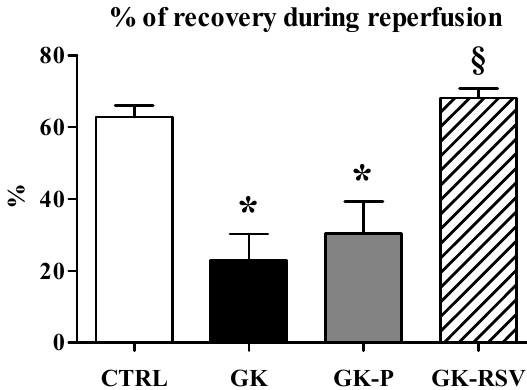
Figure 1. Myocardial function evaluated by the product of developed pressure and heart rate during the experimental time course ( A ) and % of recovery during reperfusion ( B ). Results are expressed as means ± SEM. Two-way ANOVA was performed to observe the effect of group and time. * p < 0.001 GK and GK-P vs. CTRL, † p < 0.01 GK-RSV vs. CTRL, ‡ p < 0.01 GK and GK-P vs. GK-RSV, and § p < 0.001 vs. GK and GK-P.